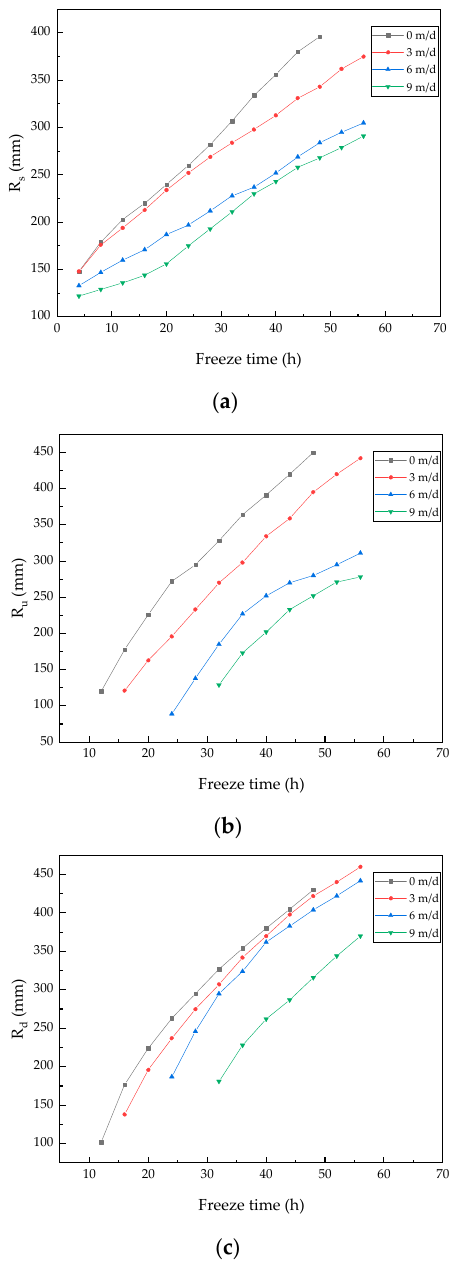
Figure 15. The development of the frozen curtain thickness at different locations for different velocities: ( a ) R s ; ( b ) R u ; ( c ) R d . The average development rates of R s , R u , and R d in the freezing process for different velocities are shown in Table 3. It can be seen from the table that R s , R u , and R d were all restrained by the flow. The larger the velocity, the slower the development of the frozen curtain thickness. Comparing the development of the frozen curtain thickness for the same velocity, it can be found that when there was no flow, the development rates of the frozen curtain thickness in the upstream and downstream were the same. Compared with R u and R d , the development rate of R s was slower. When there was flow, the development rate of R d was the largest, and the development rate of R s was the smallest. Compared with the development rates when u = 0 m/d, the development rates of R s , R u , and R d at u = 9 m/d decreased by 42%, 32%, and 14%, respectively. It can be found that the flow had the greatest inhibition effect on R s and the smallest inhibition effect on R u . Table 3. The development rate of frozen curtain thickness. Flowing Velocity (m/d)